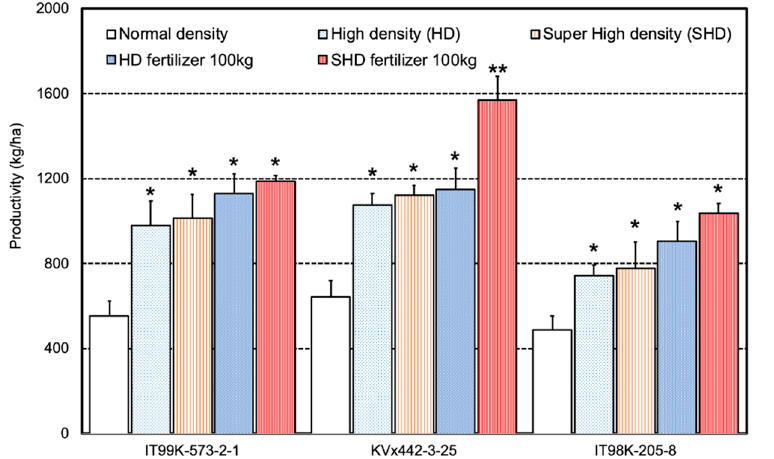
Figure 1. Effect of planting density and fertilizer treatments on cowpea seed production. Bars indicate standard deviation. Asterisks indicate significant differences using the Dunnett’s test (* = p < 0.05, ** = p <